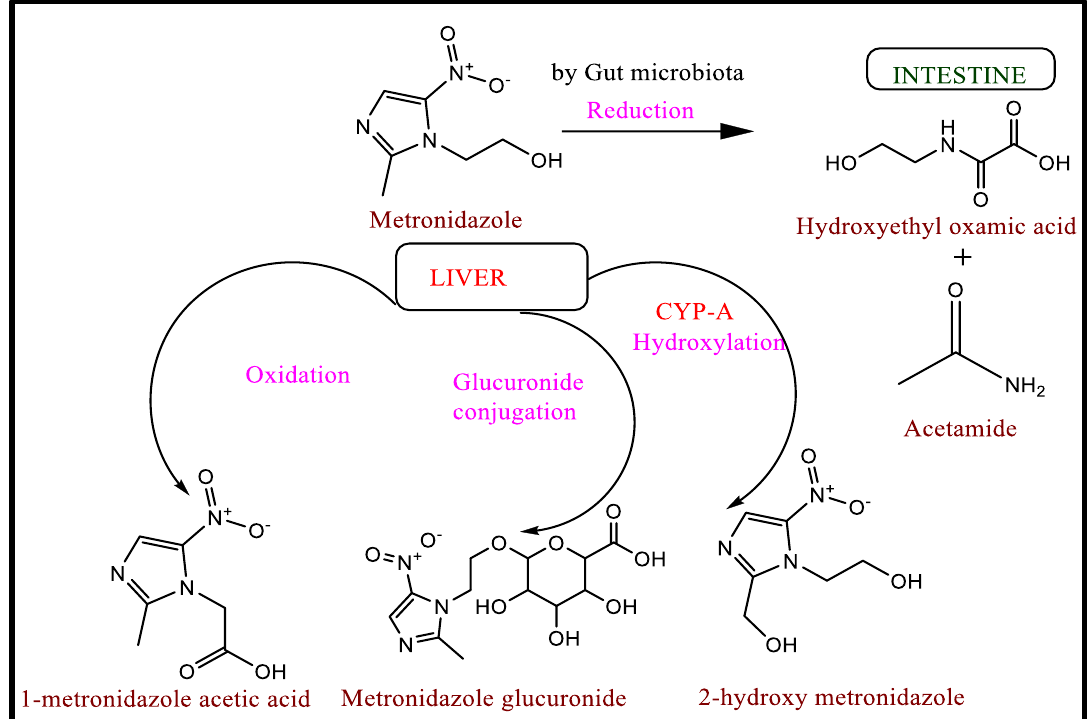
Figure 2. Metronidazole metabolism in